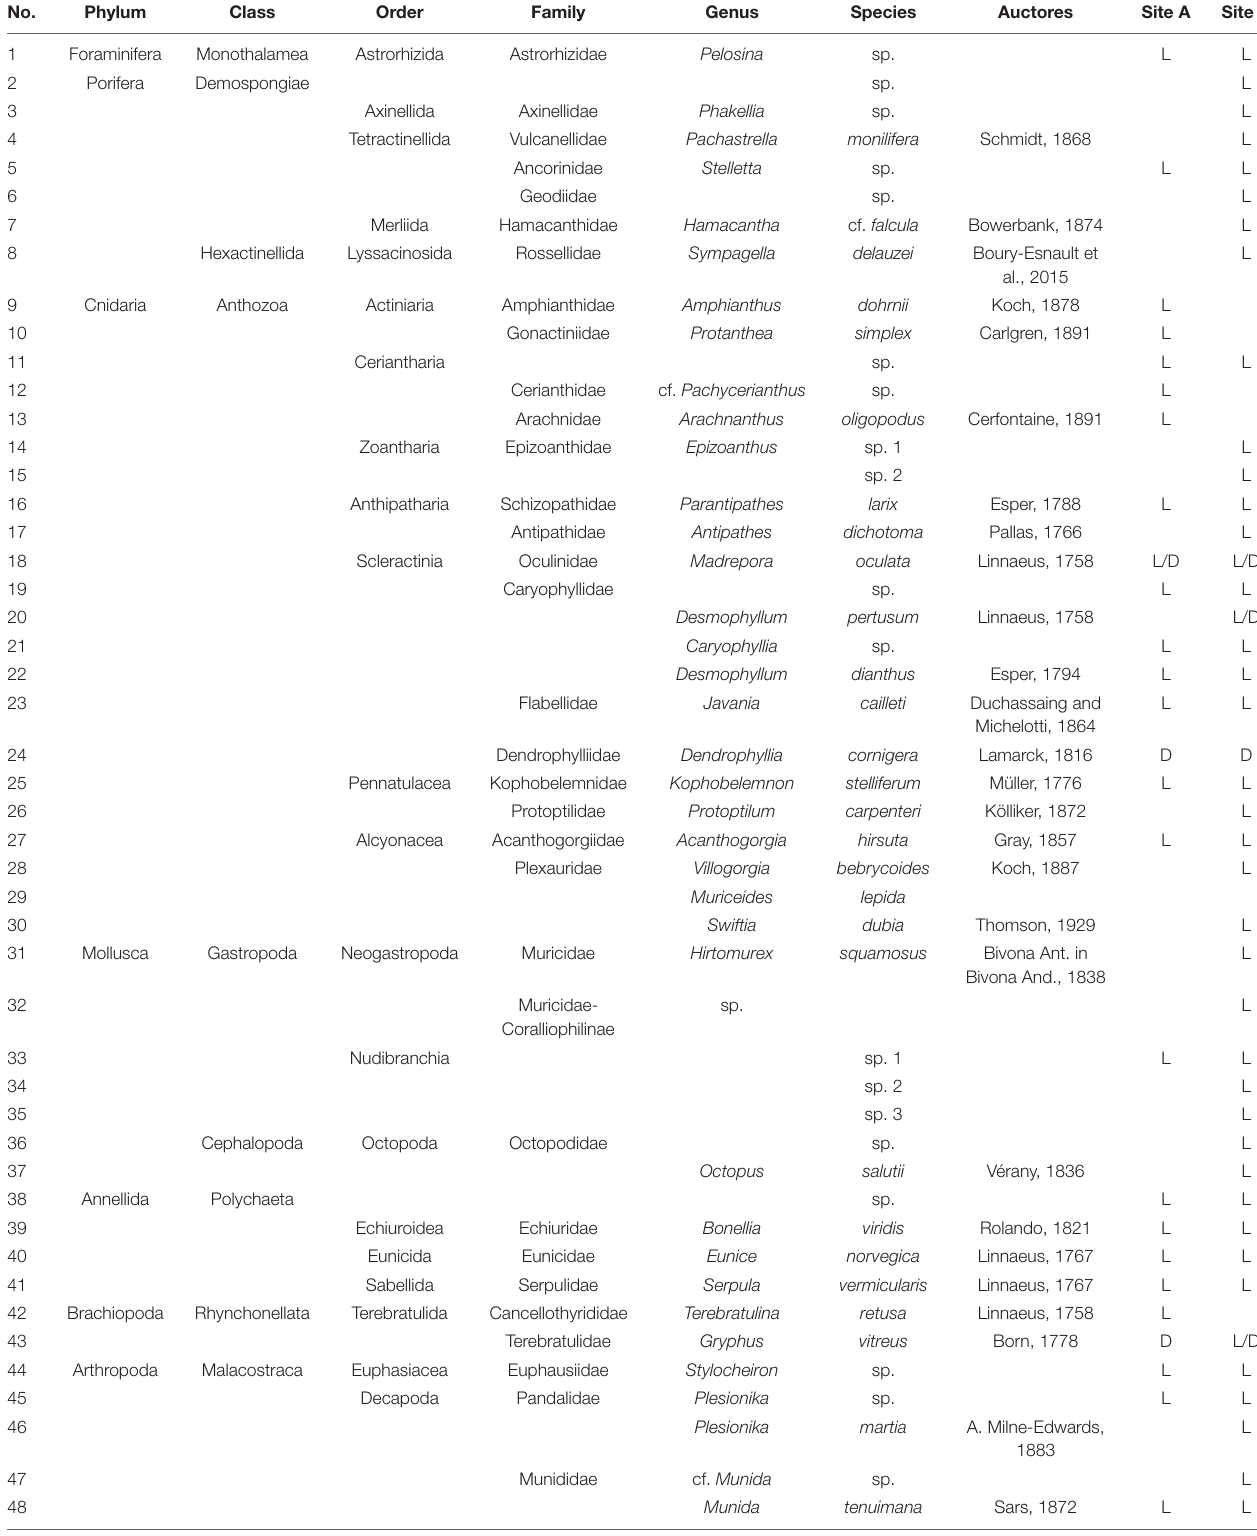
TABLE 2 | List of macroorganisms observed in the new “Corsica Channel CWC Province.” L, living observed organisms; D, dead only; L/D, specimens observed both living and dead.